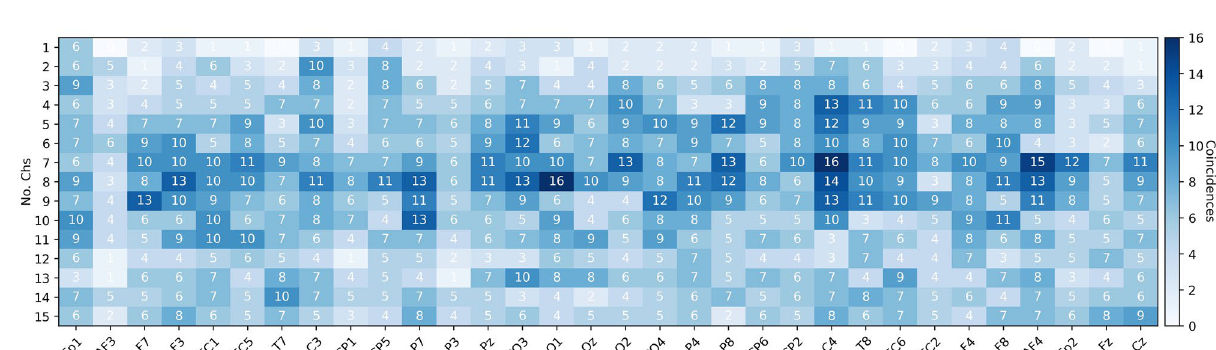
Figure 9. EEG channels selected for 2-s segments classification of low and high valence using EEGNet and NSGA-II.